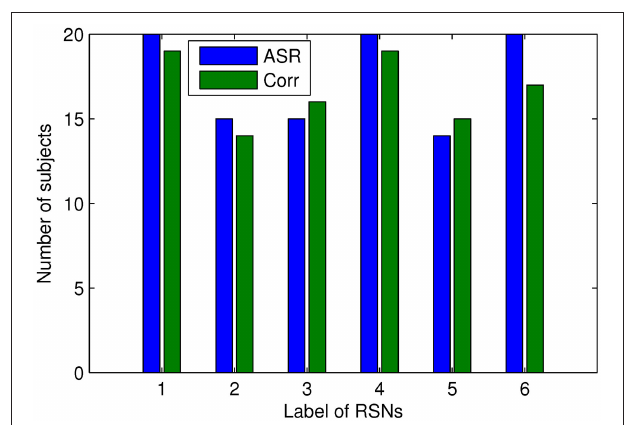
FIGURE 8 | Number of subjects reporting the presence of the above 6 RSNs. The digits “1” through “6” denote Basal ganglia, DMN, sensorimotor cortex, limbic, frontal-parietal network, and visual cortex respectively. Results of ASR and the Pearson correlation are marked in blue and green